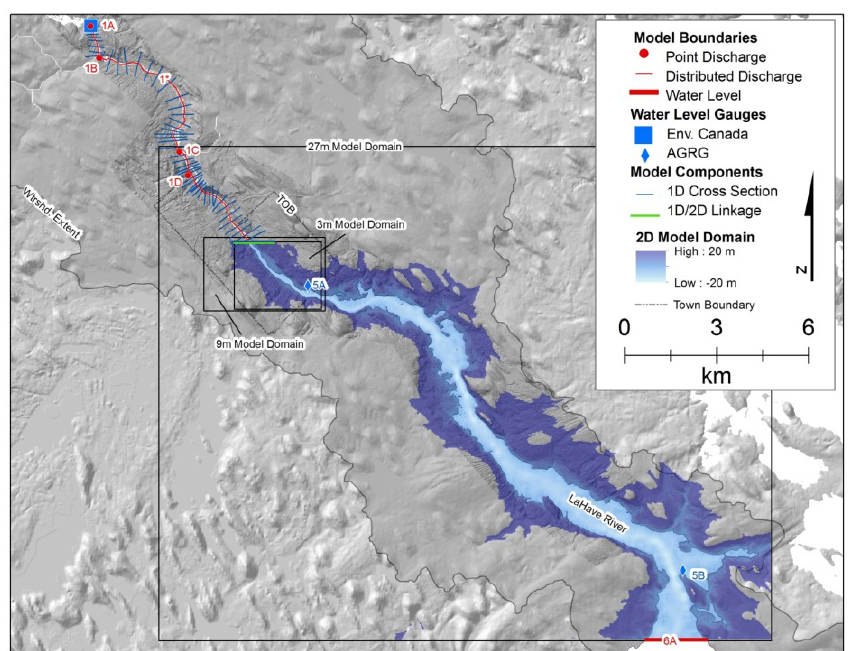
Figure 4. The model domain and boundaries of both the 1-D and 2-D components of the integrated coastal flooding simulation designed for the Town of Bridgewater (TOB). 1-D model components include: topo-bathymetric cross sections along river (in blue); 1A: the main channel discharge input; 1B, 1C, and 1D: discharge inputs for each major tributaries downstream; 1*: accumulated discharge inputs along the length of the 1-D domain (in a solid red line). 2-D model components include: three nested topo-bathymetric grids of 3 m, 9 m, and 27 m cell size; 6A: a tidal water level time series boundary; 5A, 5B: water level validation gauges deployed by